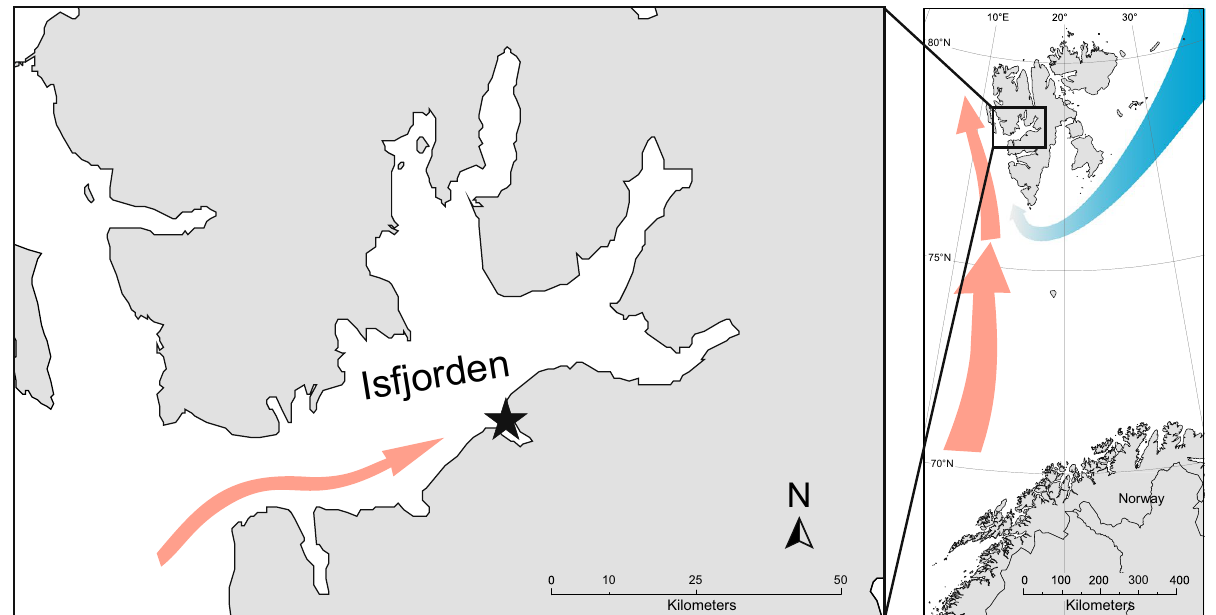
Figure 1. Location of the sampling station Isfjorden/Adventfjorden IsA (black star), Spitsbergen, Norway. The arrows show the dominating ocean currents: warm West Spitsbergen Current (red arrow) advected to the southern part of the Isfjorden and cold Sørkapp Current (blue arrow). Map was prepared with Ocean Data View software v. 5.0.0 (http:// odv. awi. de) 61